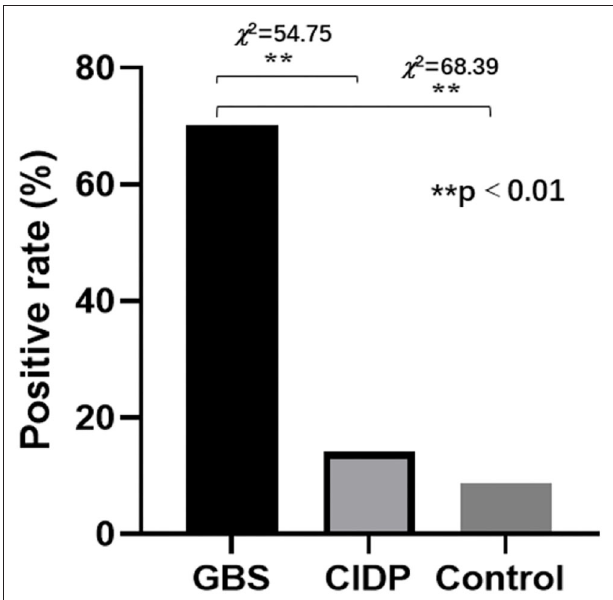
FIGURE 2 | Comparison of thyroid autoantibodies positive rates in the GBS, CIDP, and Control groups. Of the 97 patients in the GBS group, 68 (70.10%) patients were thyroid autoantibody positive. Of the 78 patients in the CIDP group, 11 (14.10%) patients were thyroid autoantibody positive. Of the 81 patients in the control group, 7 (8.64%) patients were thyroid autoantibody positive. The positive rates were significantly different between the GBS and CIDP groups ( χ 2 = 54.75 and ** P < 0.01) and between the GBS and Control groups ( χ 2 = 68.39 and ** P < 0.01). However, they were not significantly different between the CIDP and Control groups ( P > 0.05).